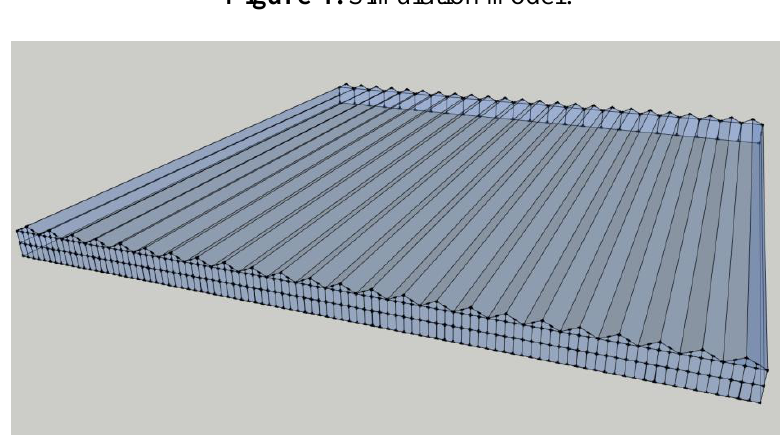
Figure 4. Simulation